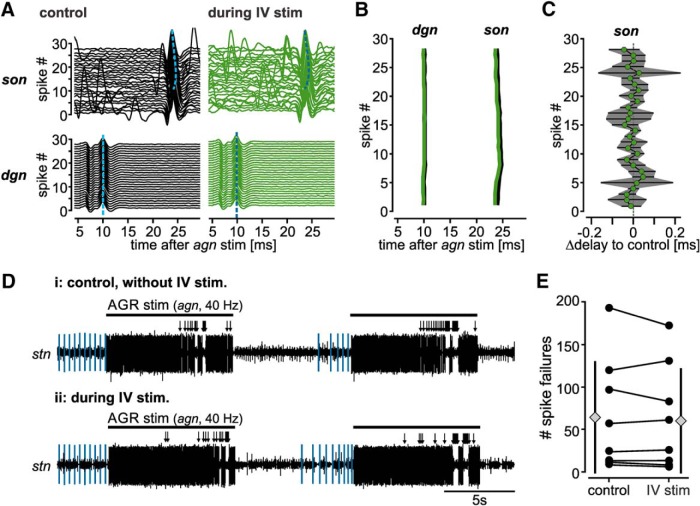
IV neuron modulation does not affect en passant AP propagation. A, Single burst of peripherally initiated AGR APs in response to extracellular stimulation of the agn with 28 consecutive pulses and 15 Hz stimulation frequency. Shown are spike appearances on the dgn (Ai) and son (Aii) before (black) and during IV neuron stimulation (green). APs were aligned to the stimulus and plotted on top of each other so that the first spike occurs at the bottom. B, Comparison of spike appearance for the example shown in A. Spike times were extracted and plotted as a function of delay to the agn stimulation. C, Analysis of the temporal difference in spike appearance on the son before and during IV stimulation for 28 consecutive APs. Δdelay is the difference in AP arrival time on the son during IV stimulation and the no IV stimulation control. Shown are means ± SD. N = 6 preparations, n = 28 APs each condition. D, Example extracellular recording of the stn showing spike failures (arrows) of AGR APs before and during IV neuron stimulation. Ectopically generated AGR spikes are highlighted in blue while agn stimulation induced APs are depicted in black. AGR was activated in the periphery via extracellular stimulation of the agn. Recordings are from the same preparation. E, Analysis of the number of spike failures during 10 repetitive agn stimulations (40 Hz, 9 s train/intertrain duration, 360 APs/train) before (control) and during IV stimulation. Circles represent data from single experiments; diamonds represent means ± SD, N = 8 preparations.